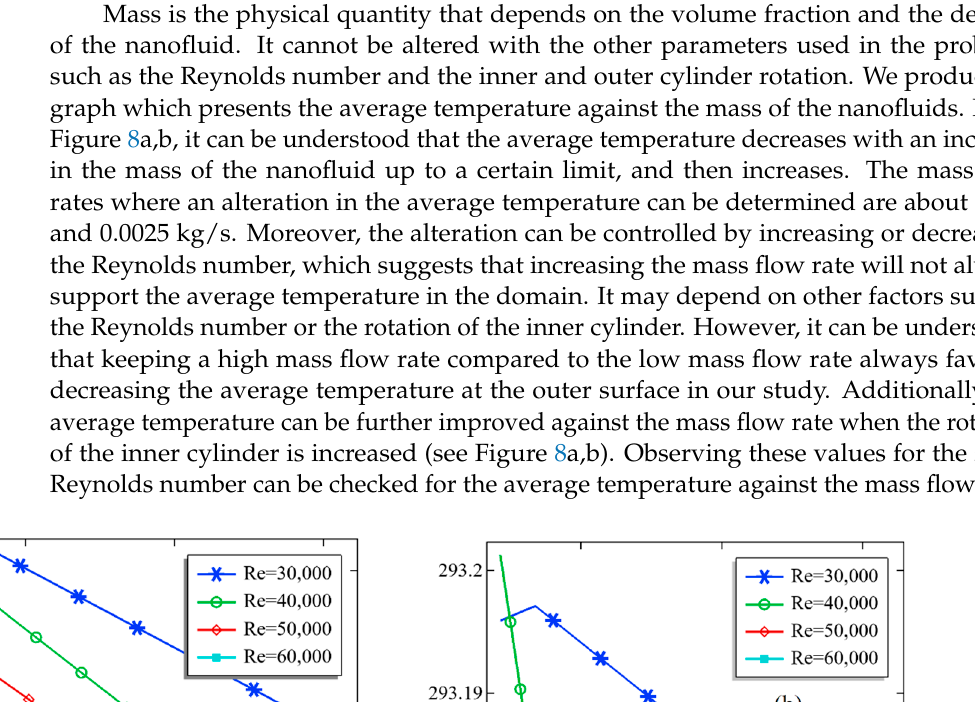
Figure 7. The increasing mass of the nanofluid and volume fraction of the outer cylinder.